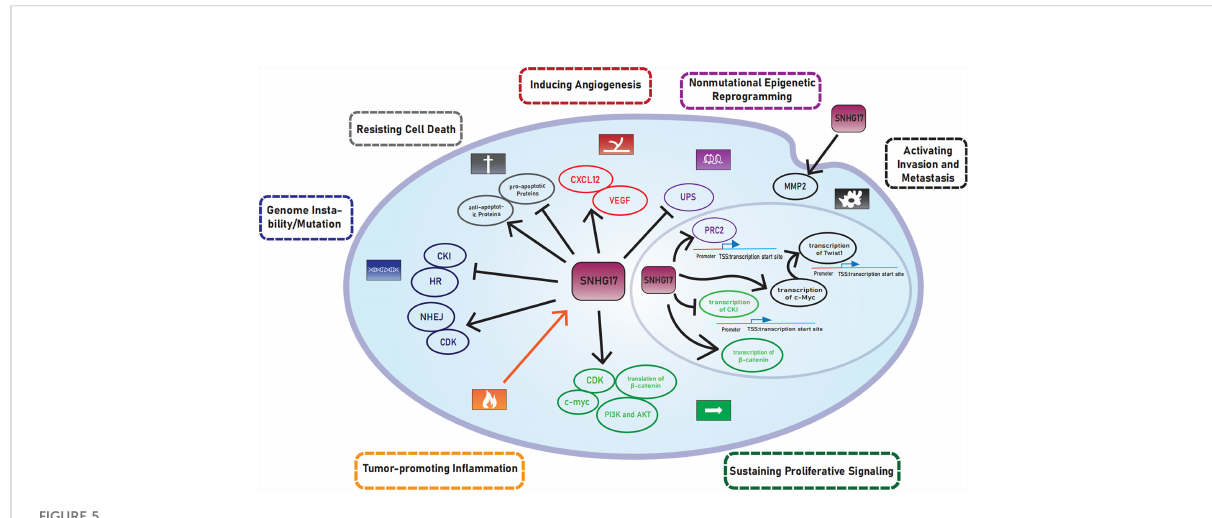
FIGURE 5 The relationship between SNHG17 and cancer hallmark.